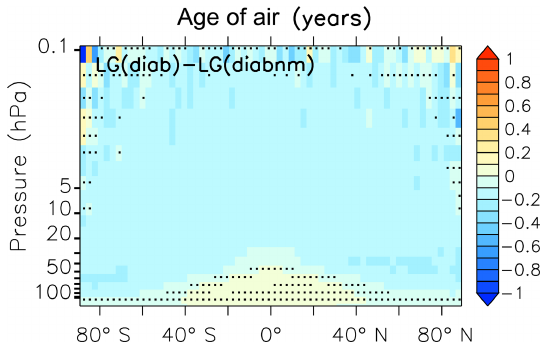
Figure 14. Zonal mean mass fluxes through the 380K (black), 400K (red), and 500K (green) isentropes. Upward (solid line) and downward (dashed line) mass flux from the LG(diab) simulation as a mean over 1960–2010.